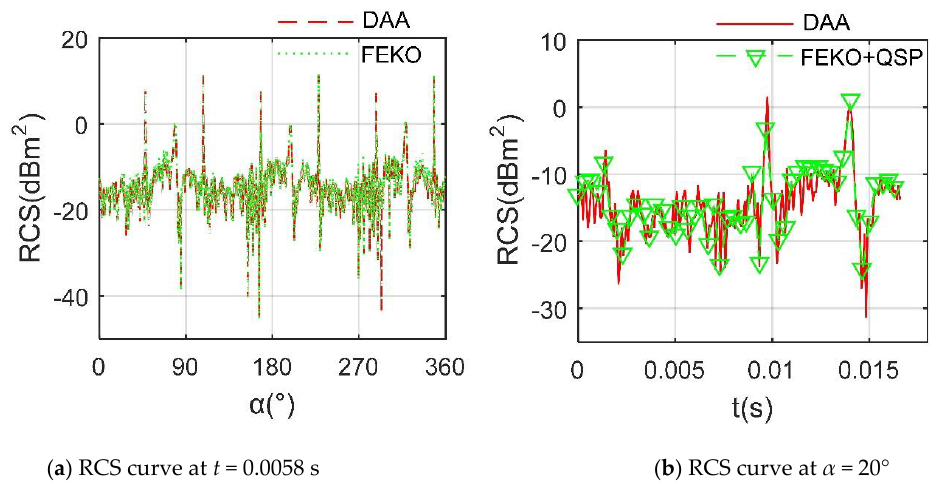
Figure 2. The validation of the radar cross-section (RCS) algorithm on rotor 1, f RH = 10 GHz, β = 10°.